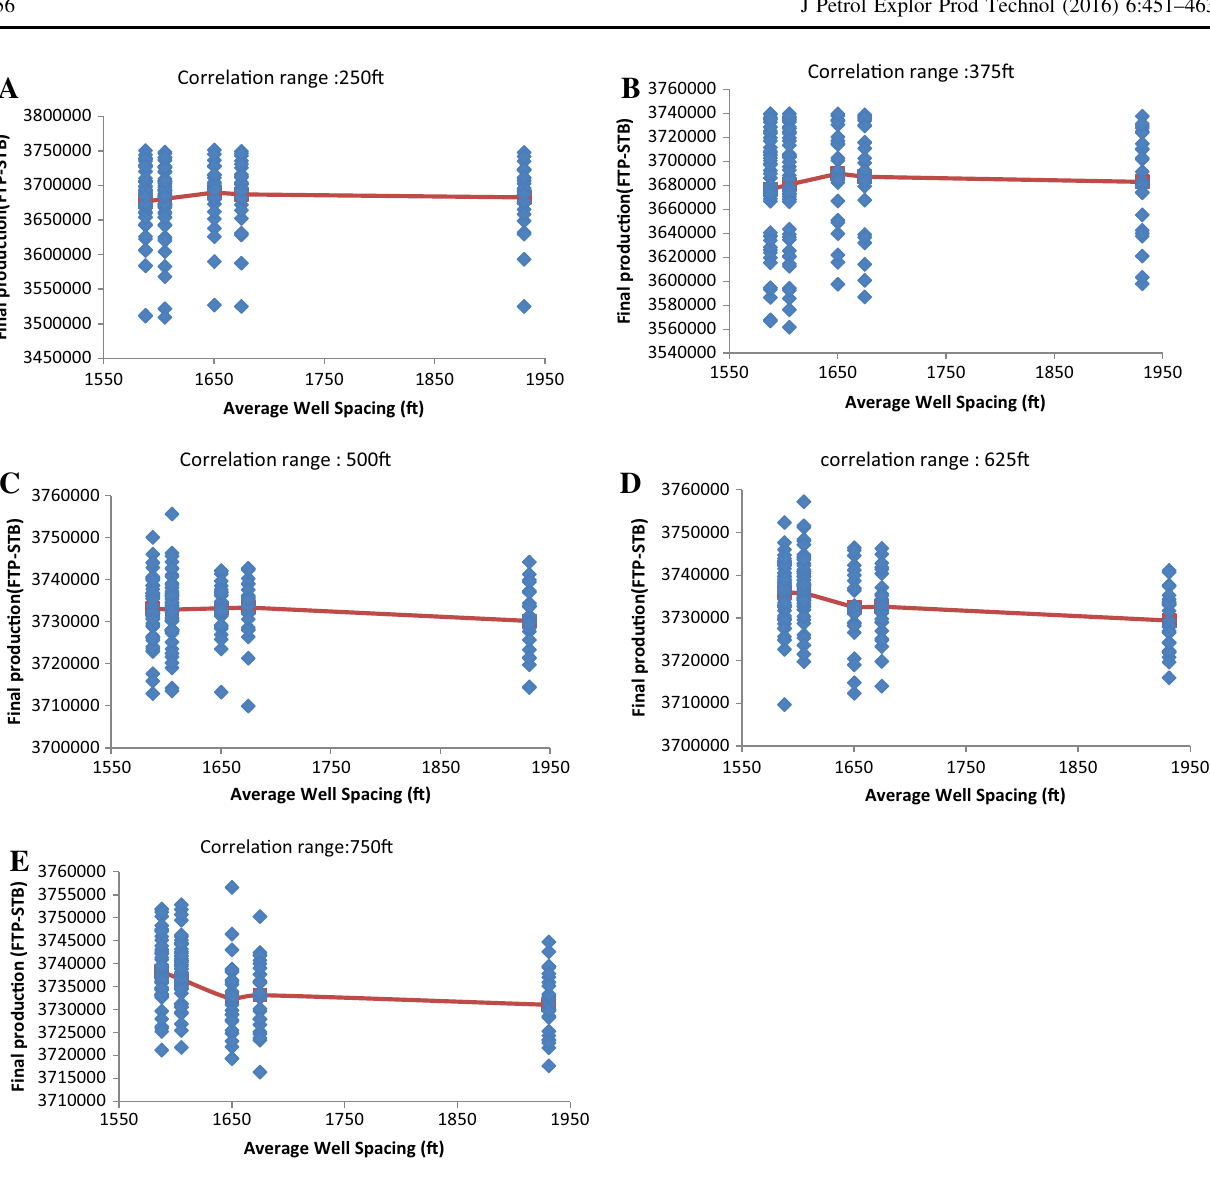
Fig. 4 Final production versus average well spacing for each correlation ranges (from diagram a – e ): 250, 375, 500, 625, and 750